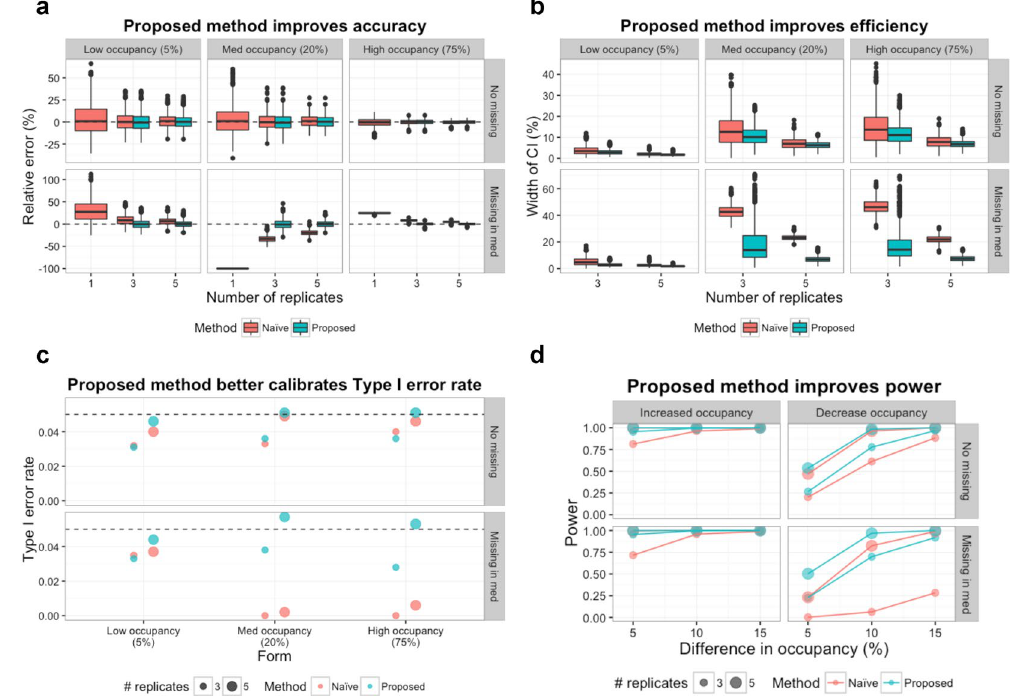
Figure 4. Simulation analysis for site occupancy estimation and detection of differential site occupancy. A scenario of three forms with occupancy of 5%, 20% and 75% for each is considered, where mean and standard deviation of log2-intensity are set to 25 and 0.2, respectively. The results by the naïve and proposed methods are compared based on 1000 simulations. ( a ) Relative errors of site occupancy estimates (i.e., estimation error divided by the true value), with different number of replicates and presence of missing data. ( b ) Widths of the 95% confidence intervals. ( c ) Type I error rate based on a statistical significance level set at 0.05. The horizontal dashed lines indicate the theoretical Type I error. The dots indicate the actual Type I error across 1000 simulations. ( d ) Statistical power to detect differential site occupancies with differences of 5%, 10% and